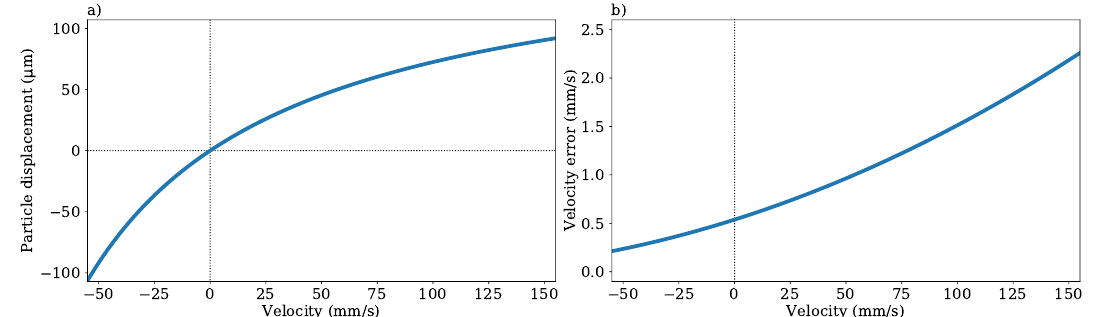
Figure 4. ( a ) Particle displacement between the image frames plotted against the particle velocity. ( b ) Velocity error per bin plotted against the particle velocity, assuming a half-pixel particle position error and 100 particles in each